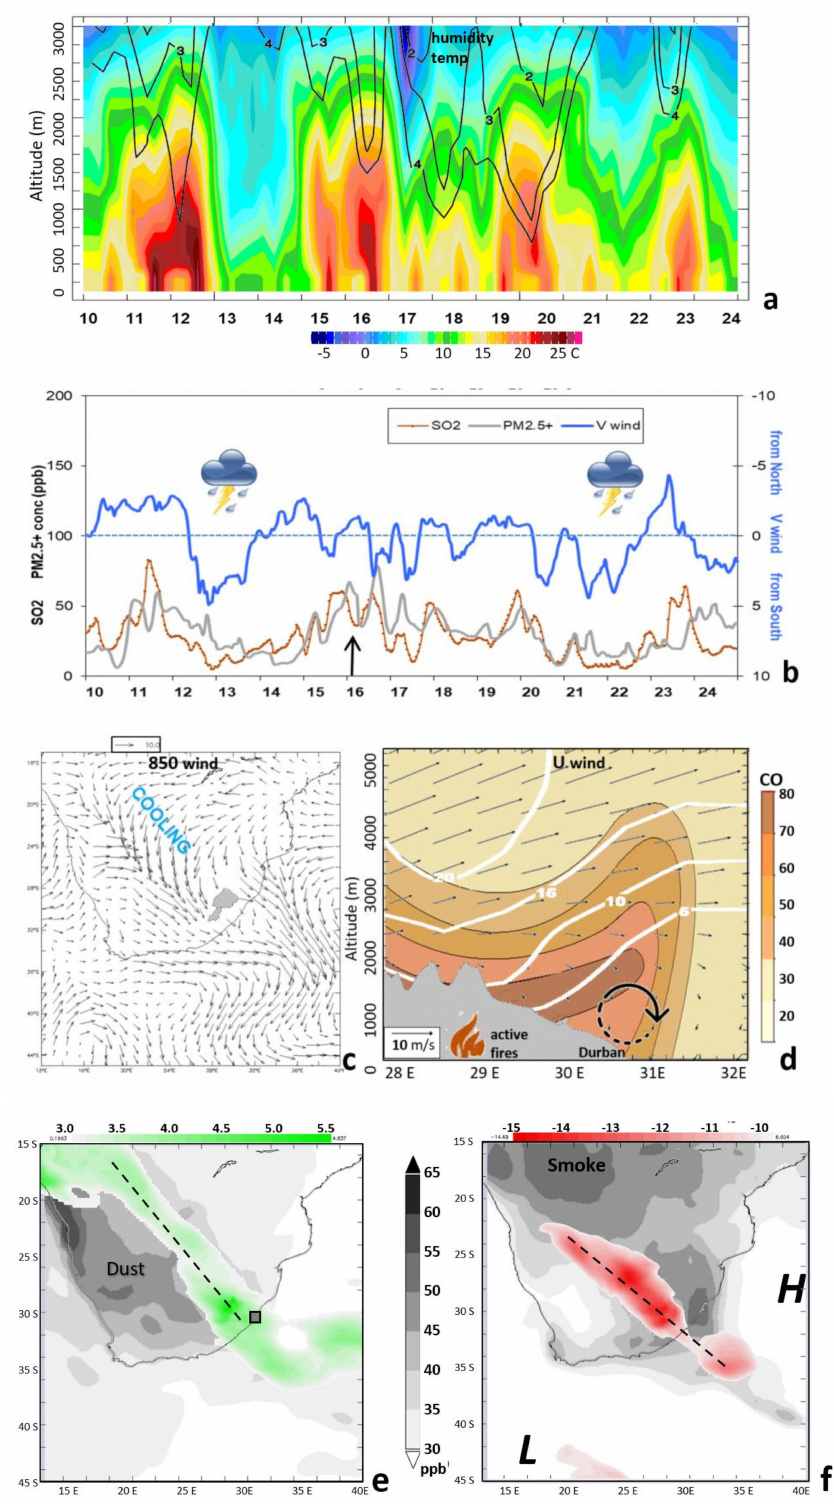
Figure 8. Case of 10–24 July 2015: ( a ) time–height air temperatures (shaded C) and specific humidity <4 g/kg (contours), ( b ) time series of hourly SO 2 , PM 2.5 , -V wind, & rain icons. 15–16 July 2015, ( c ) 850 hPa wind (m/s), nocturnal cooling (blue) and highlands (grey), ( d ) vertical section on 29.8 ◦ S of CO (shaded ppb) and zonal circulation (vectors) with white speed contours and leeward eddy, ( e ) grey-shaded dust (PM 2.5 ) and green-shaded 700 hPa humidity > 3 g/kg, and ( f ) grey-shaded smoke and red-shaded 700 hPa V wind < − 10